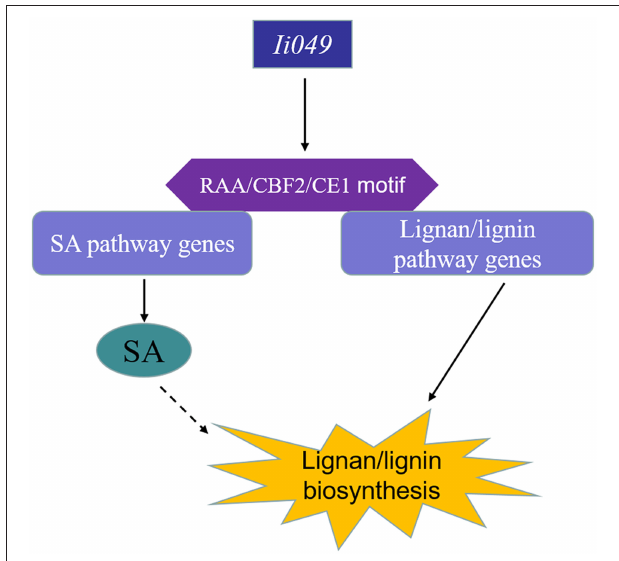
FIGURE 9 | Schematic model of lignan/lignin biosynthesis regulated by Ii049 . Ii049 , an AP2/ERF transcription factor in I. indigotica ; RAA/CBF2/CE1 motif, cis-element in genes promoter